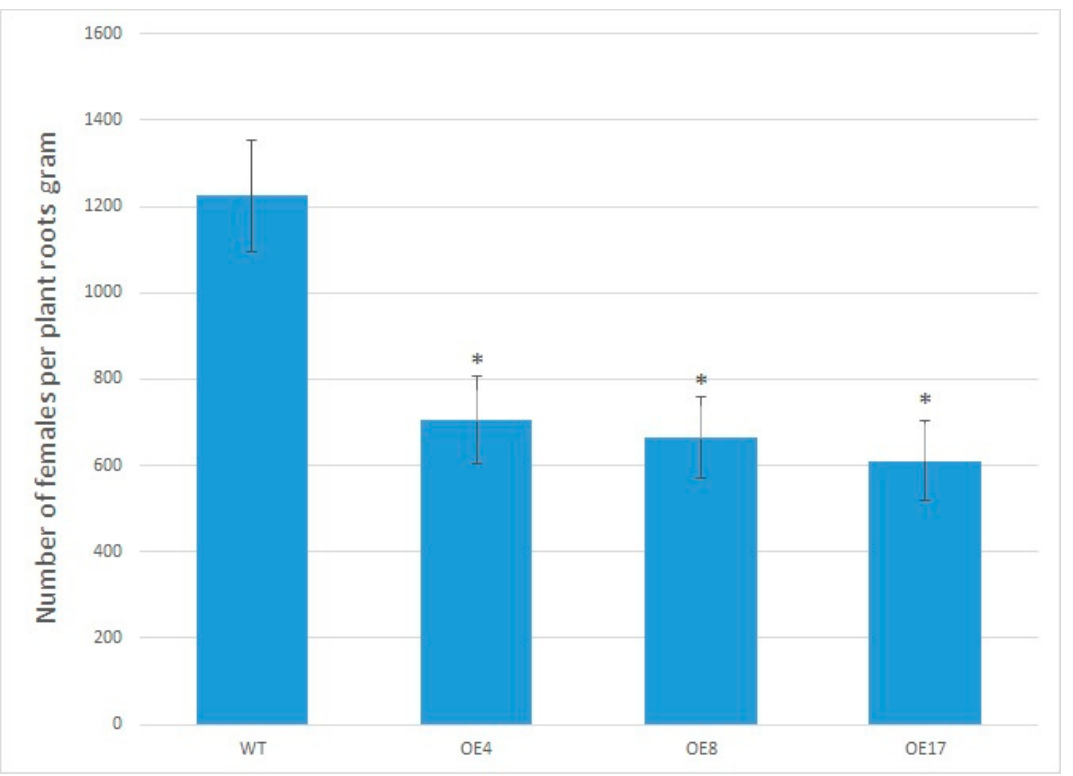
Figure 7. Meloidogyne incognita infection analysis in Arabidopsis OE lines. Average number of RKN females per plant roots of Arabidopsis WT plants and three OE lines (OE4, 8, and 17) at 60 days after inoculation with M. incognita . Values are means ± standard error of 10 individuals. Statistical analyses were performed using t -test and asterisks indicate significant differences ( p < 0.05).